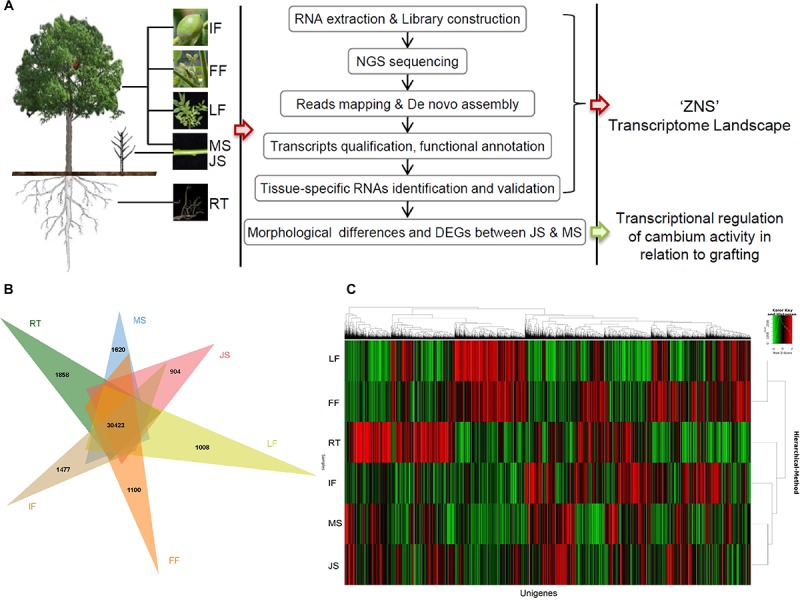
Overview of the experimental design and the general picture of “ZNS” transcriptome landscape. (A) Experimental protocol. (B) Distribution of unigenes expressed in different organs/tissues. (C) Hierarchical clustering analysis of unigenes expressed in all six libraries. RT, root; MS, new shoot of adult “ZNS” seedling tree; JS, new shoot of grafted “ZNS” tree; LF, leaf; FF, female flower; IF, immature fruit.